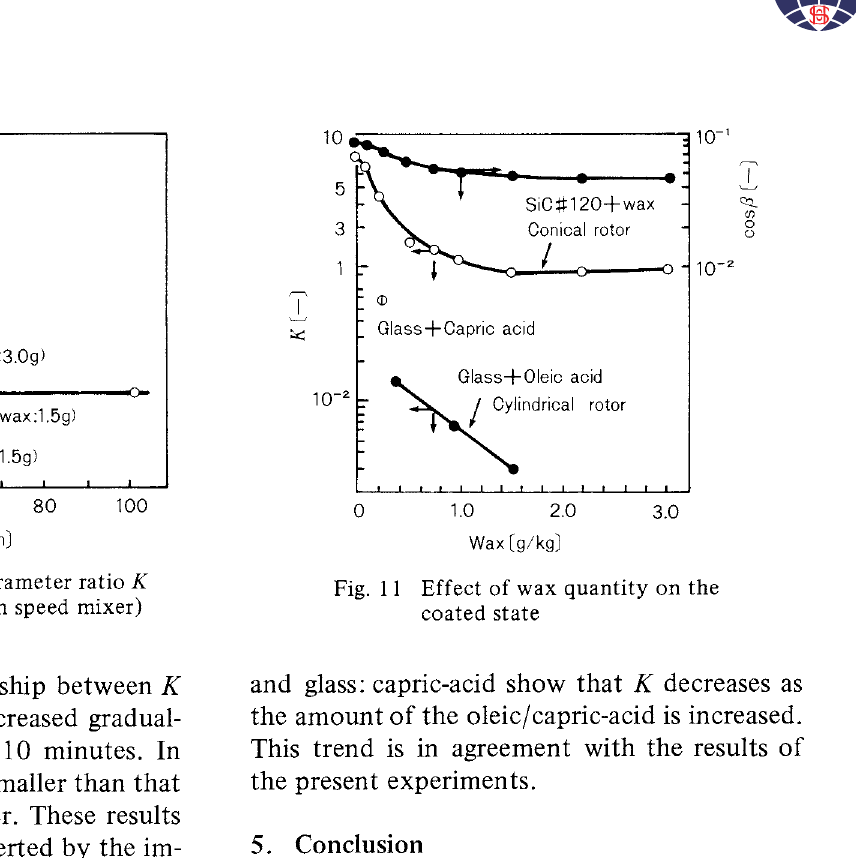
Fig. 1 0 Relationship between parameter ratio K and mixing time 8 M (high speed mixer)